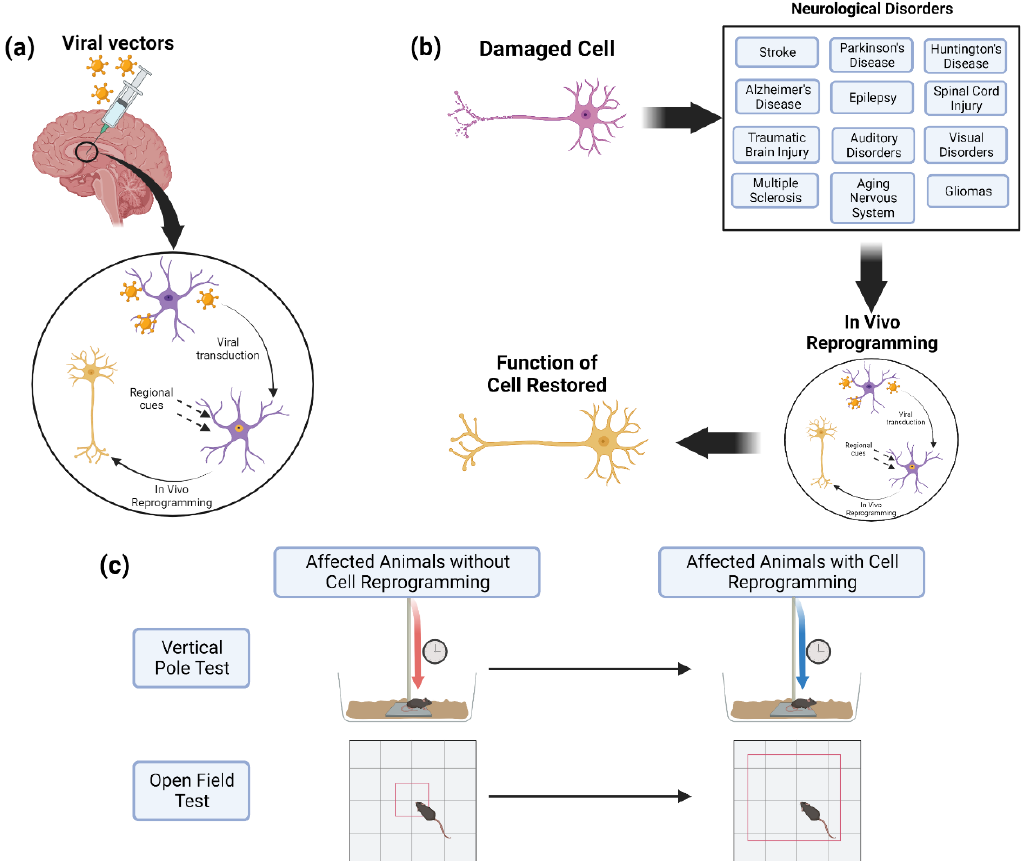
Figure 1. In vivo cell reprogramming. Current research into cell reprogramming has focused on translating the approach to in vivo models of neurological disorders to determine the extent of nervous system repair. ( a ) Reprogramming factors are commonly administered to target cell populations through viral transduction. Viral vectors loaded with the reprogramming transcription factor controlled under a target cell-specific promoter is injected into the site of reprogramming interest to induce in vivo cell reprogramming in transduced target cells. ( b ) One significant benefit to cell reprogramming as a therapeutic approach is its adaptability toward targeting various neurological disorders for nervous system restoration. Cell damage and loss is a common pathology across several neurological disorders where in vivo reprogramming would serve to replenish lost cell populations and recover cell function. ( c ) Functional recovery remains a significant outcome measure of successful in vivo reprogramming in animal models of neurological disorders where animals would hypothetically display functional improvements in behavioral assays.